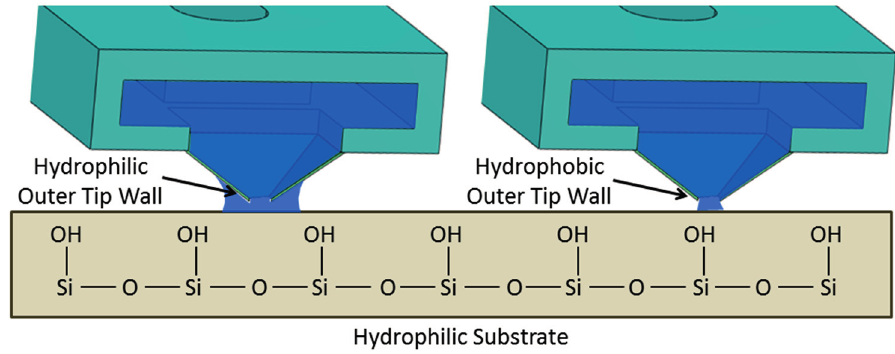
is hydrophilic ( left panel ) and small when the tip is hydrophobic ( right panel